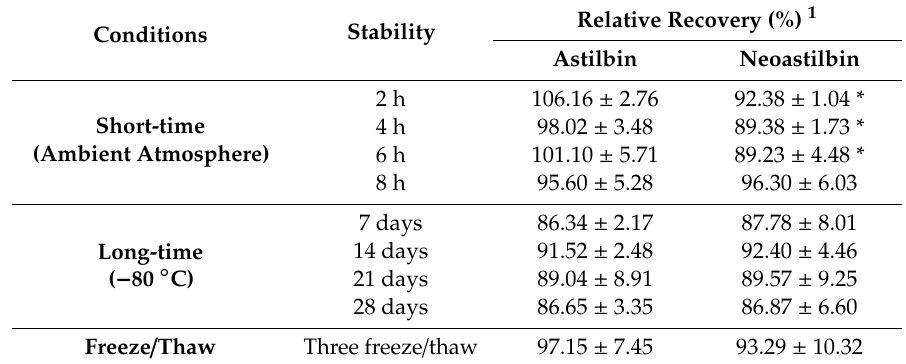
Figure 4. The stability of astilbin in extracting supernatant during concentration at 75 ◦ C; * means significant di ff erence ( p < 0.05) and ** means very significant di ff erence ( p < 0.01) between the two treatments. Table 1. Stability of astilbin and neoastilbin in plasma (1 µ g / mL) under di ff erent store conditions. (n =